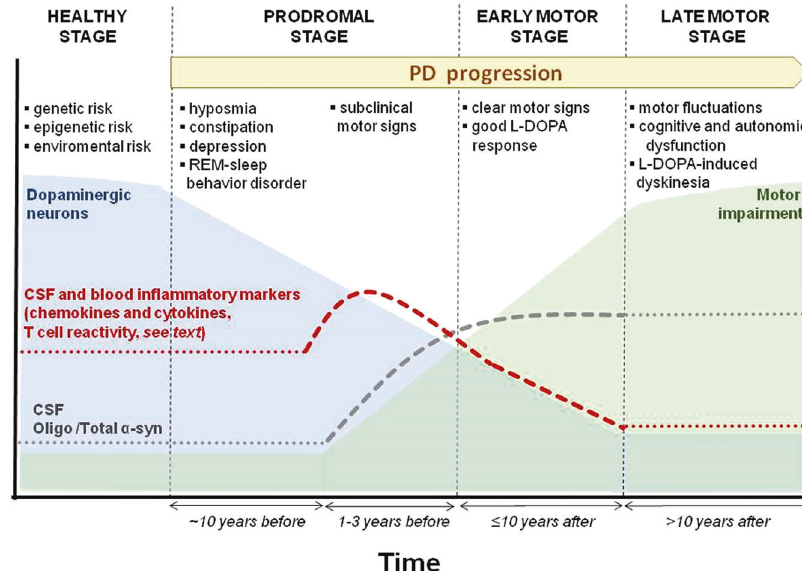
Fig. 4 Hypothetical sequences of signs and biomarkers in PD stages. In the healthy presymptomatic stage, the number of dopaminergic cells of SNpc slowly decreases (light blue curve), and clinical symptoms are absent. In prodromal PD, neurodegeneration starts with a rapid decrease in nigral neurons survival rate (light blue), non-motor symptoms, and signs of neurodegeneration are evident; peripheral in fl ammatory markers begin to increase (red dashed line). Subsequently, there is an increase in in fl ammatory markers, which decreases gradually in the early motor stage (red dashed line). The oligo α -syn/total α -syn ratio (gray dotted line) is elevated in both prodromal and early motor stages. In addition, the evolution of the motor impairment is represented by a green curve, especially during the late motor stage, when long-term complications of dopaminergic therapy emerge (motor fl uctuations and dyskinesia). The dotted lines represent a hypothetical estimation. The duration of the healthy stage is unknown, while the prodromal stage can range between 10 and 15 years. Cell Death and Disease (2023)